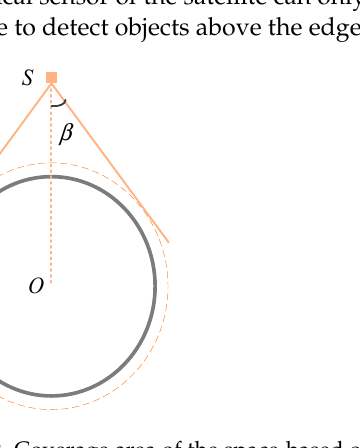
Figure 2. Coverage area of the space-based optical sensor. In Figure 2, O is the center of the earth and S is the space-borne optical sensor. The solid circle represents the sphere model of the Earth, and the dotted circle represents the edge of the Earth’s atmosphere. The sensor covers a sector beyond the tangent line of the satellite to the Earth’s